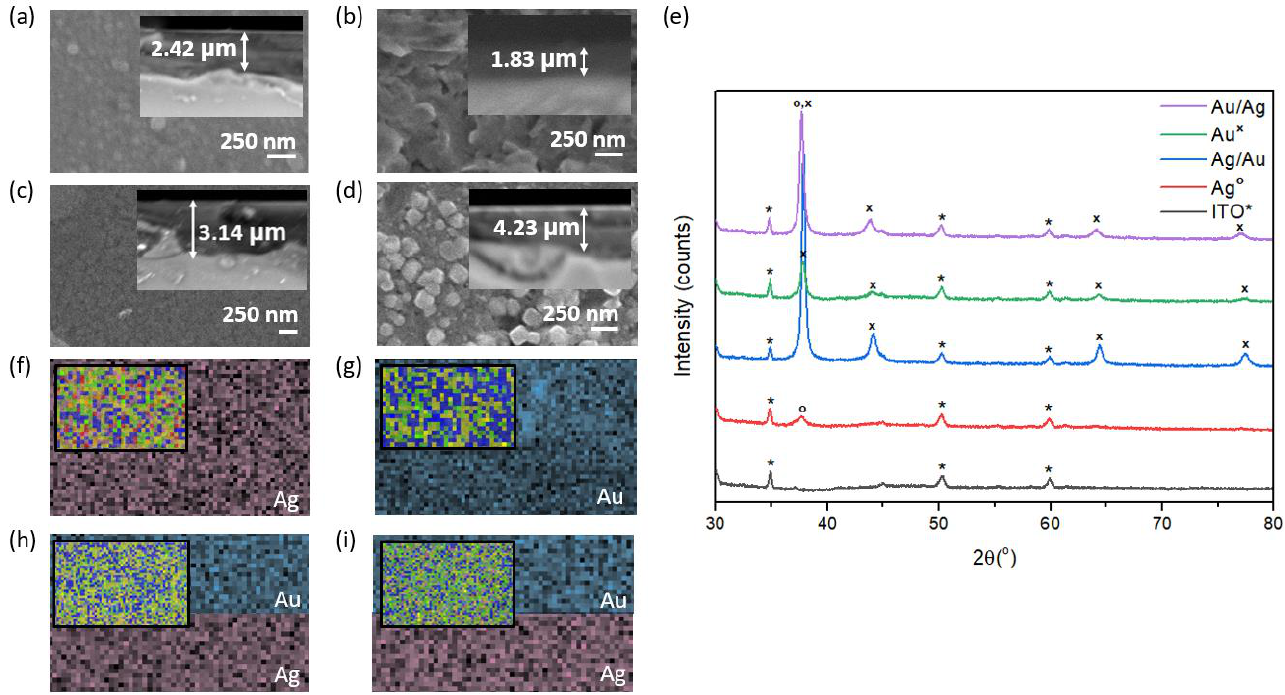
Figure 1. The results of the SEM analysis of the ( a ) Ag, ( b ) Au, ( c ) Ag/Au, and ( d ) Au/Ag thin films. ( e ) The results of the XRD analysis of the thin films. The results of the EDX analysis of the ( f ) Ag, ( g ) Au, ( h ) Ag/Au, and ( i ) Au/Ag thin films (inset: composition of all parts of the film). * is ITO, ° is Ag, and x is